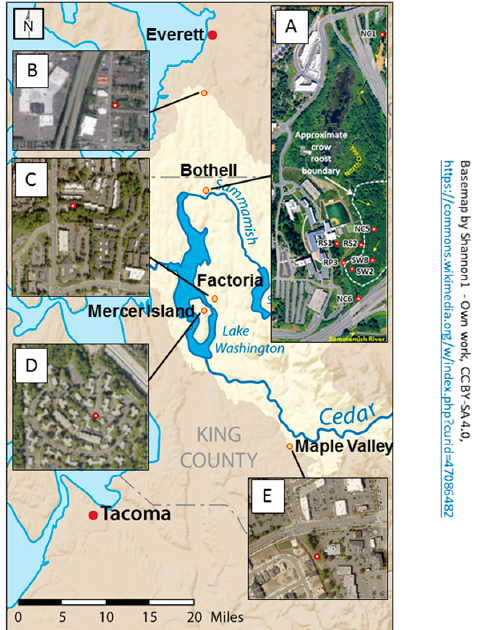
Figure 1. Map showing the locations and characteristics of the sampling areas for the study. The base map indicates that the sampling sites are all in the Lake Washington Watershed (outlined in light tan) of western Washington State. The primary sampling area, displayed in aerial photograph ( A ), is in the 58 acre restored floodplain wetland on the University of Washington Bothell/Cascadia College campus. Red markers indicate locations of surface water collection sites. Site label initials reflect different water characteristics: RS = Runoff Swale; RP = Runoff Pond; SW = Surface Water; NC = North Creek. Water sampled at RS1, RS2, and RP3 flows to these locations via a series of catch basins and pipes from the upland (western) portion of the campus. North Creek originates in Everett and flows south from NC1 to NC6 before discharging into the Sammamish River. Aerial photographs ( B – E ) show the urbanized characteristics of surrounding sites (red circles with white centers) where crow fecal samples were collected off campus. (Open source basemap from Shannon1 on Wikimedia. Aerial photograph A from the 2017 UW Bothell Master Plan. Aerial photograph B from Map Everett. Aerial photographs ( C – E ) from King County